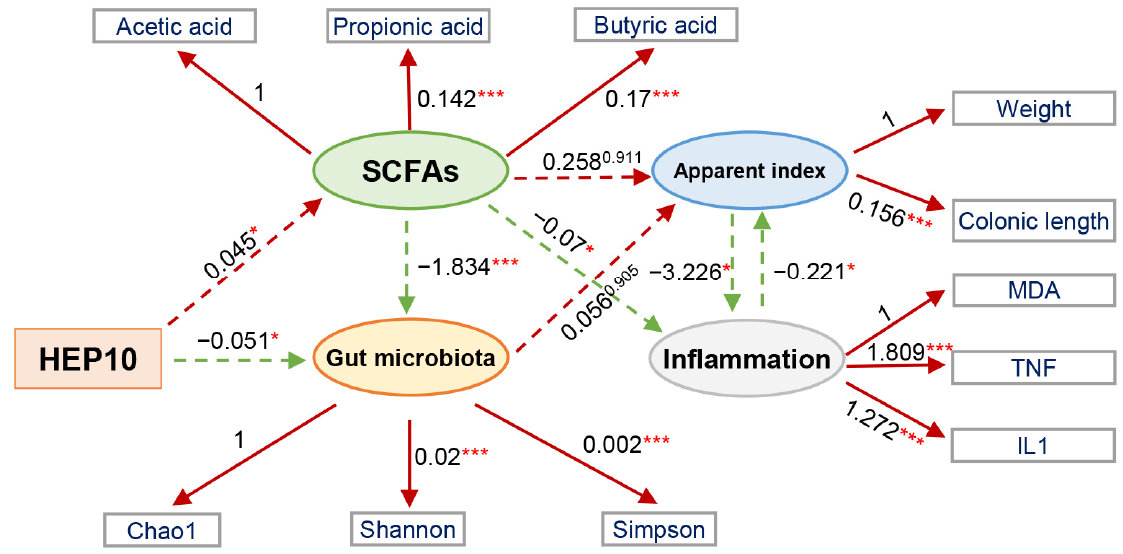
Figure 9. The structural equation modeling showed the indirect (dashed arrows) effects and direct (continuous arrows) effects of HEP10 on an apparent index, the abundance and diversity of bacteria, SCFAs, and inflammatory markers. Positive and negative relationships are indicated by red and green arrows, respectively. Significance levels are: * p < 0.05; *** p < 0.001.